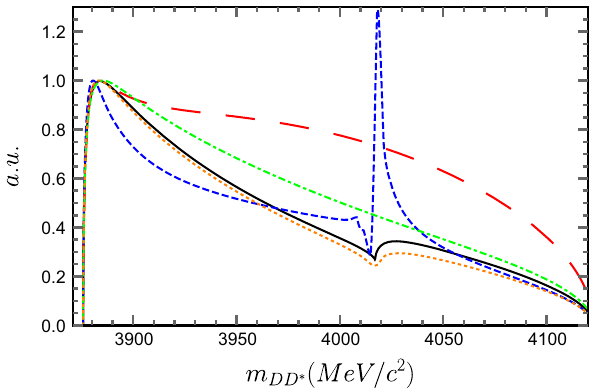
Fig. 5 Line shapes for different coupled-channels calculations: Only D ¯ D ∗ channel(red,long-dashedline), D ¯ D ∗ + D ∗ ¯ D ∗ (blue,dashedline), ρη + D ¯ D ∗ (green, dot-dashed line), ρη + D ¯ D ∗ + D ∗ ¯ D ∗ (orange, c c dottedline)and π J /ψ + ρη c + D ¯ D ∗ + D ∗ ¯ D ∗ (black, solidline).All the line shapes are normalized to coincide at the Z c ( 3900 ) ’s peak position, according to the normalization of Table 1. See text for discussion